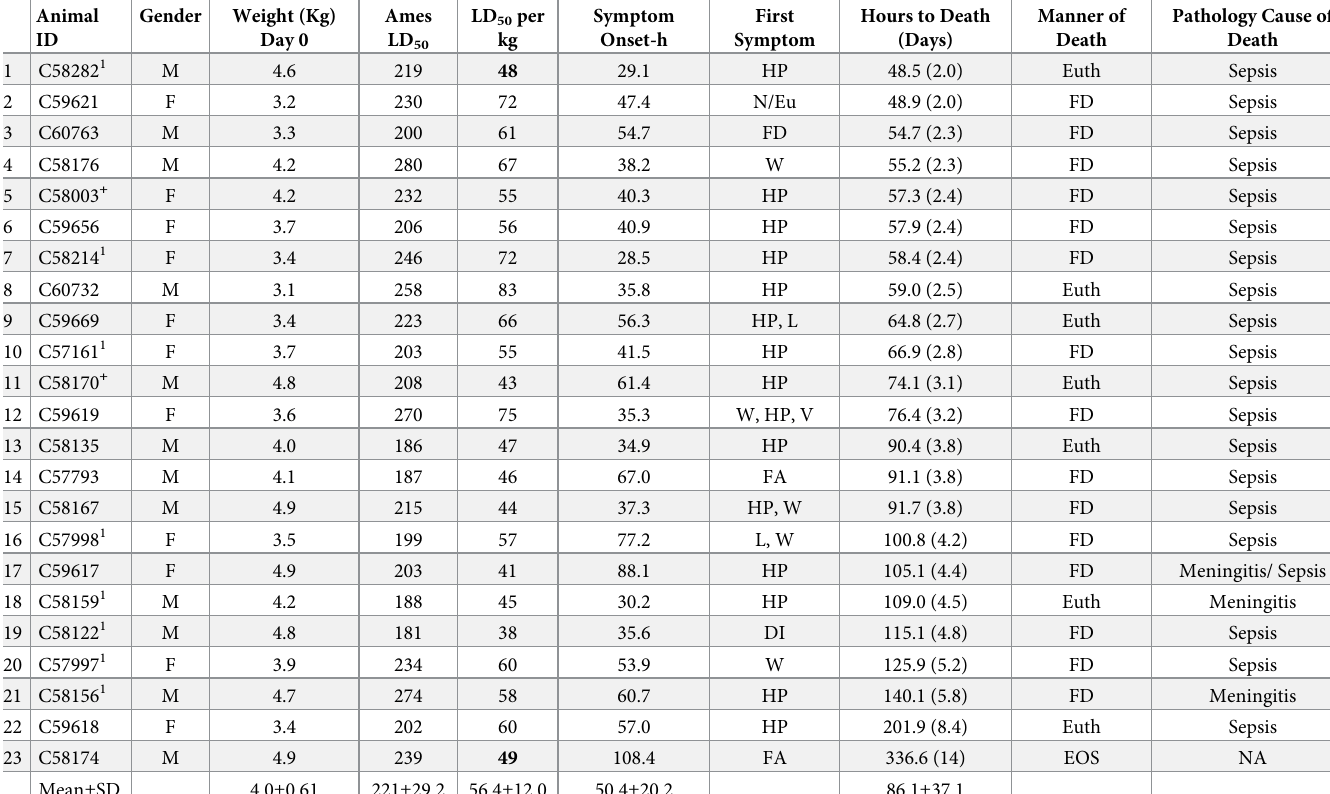
Table 1. Cynomolgus macaques, challenge, symptoms, and survival